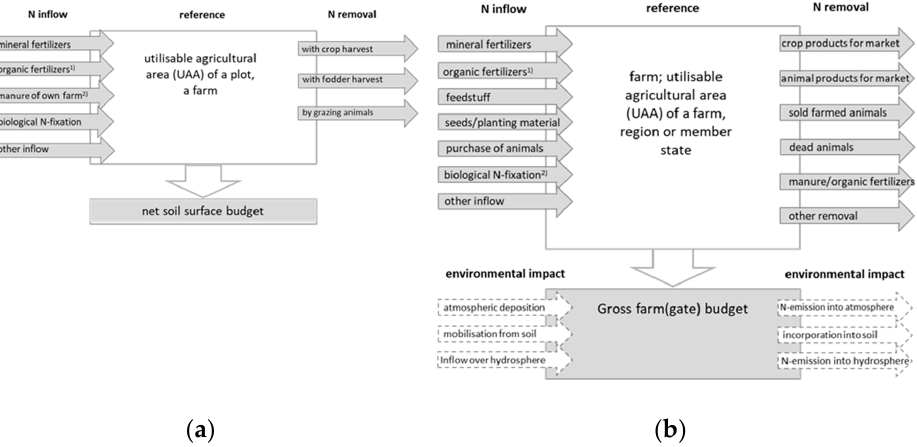
Figure 1. ( a ) Net (soil) surface budget [3,27]: (1) manure from other farms, organic and organic-mineral fertilizers: reductions are made for nitrogen losses due to a volatilization during fertilizer application to the land; (2) N in manure production by livestock, calculated by N excretion (using standard coe ffi cients), reductions are made for nitrogen losses due to volatilization in stables, storages and with application to the land. Source : [3,27], translated. ( b ) Gross farm (gate) budget [27,28]: (1) all kinds of organic fertilizers including manure. Source : [27,28], translated.